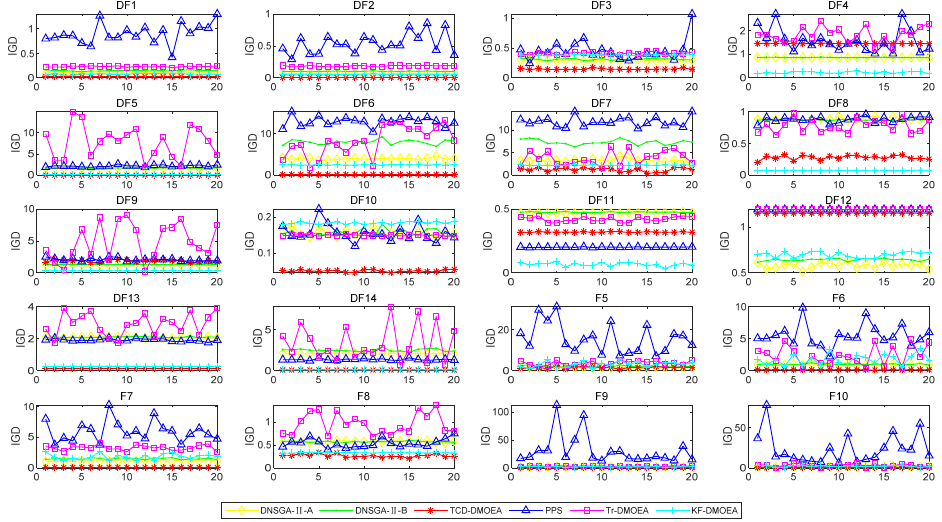
Figure 5. IGD values of six algorithms under S2 con fi guration .